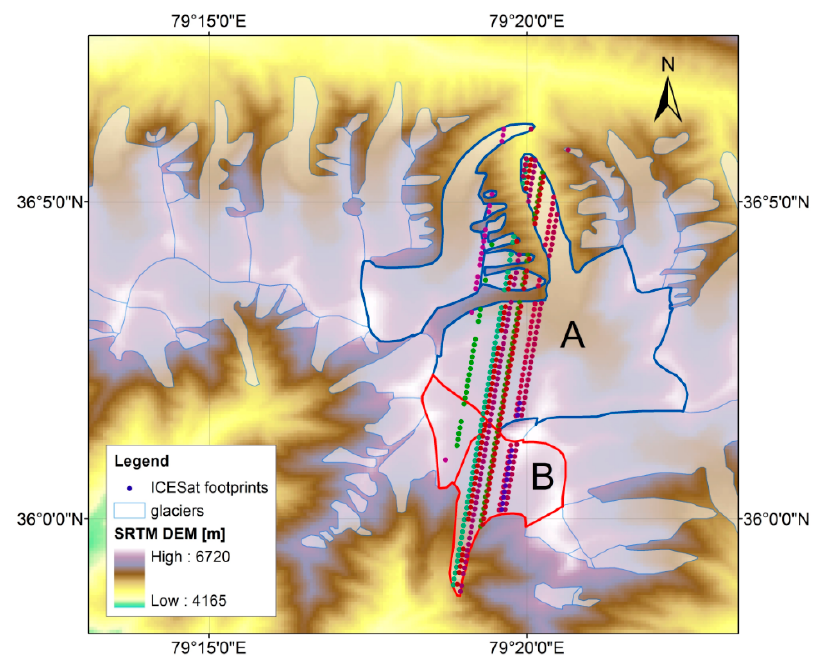
Figure 2. The ICESat-sampled glaciers having similar orientation were grouped into glaciated areas A and B in the Western Kunlun Mountains.